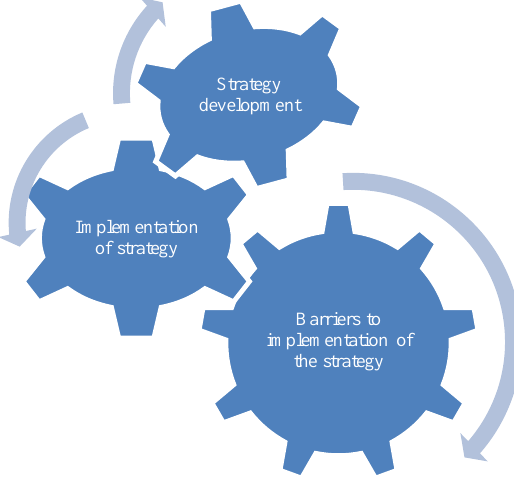
Figure 1. The relationship between strategic implementation and strategy